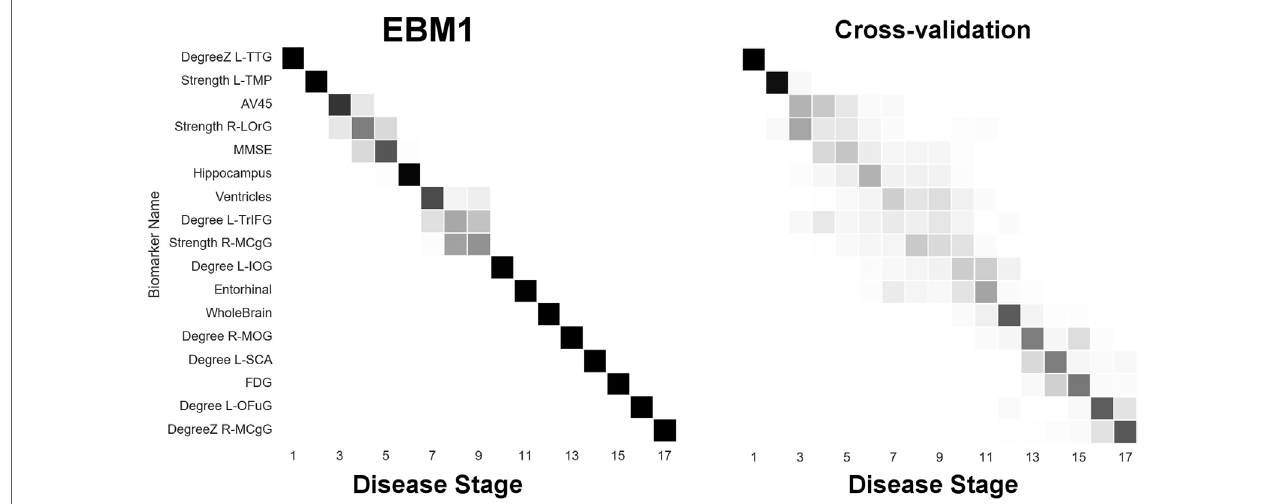
FigUre 6 | EBM for hubs in the brain’s anatomical network, along with selected standard (non-network) biomarkers, built on data from our anatomical connectome cohort, The168 . Left panel: left-right positional variance of the maximum-likelihood sequence. Right panel: cross-validation of the sequence from bootstrapping. Abbreviations: DegreeZ, degree z-score; L, left; R, right; TTG, transtemporal gyrus; TMP, temporal pole; LOrG, lateral orbital gyrus; TrIFG, triangular inferior frontal gyrus; MCgG, middle cingulate gyrus; IOG, inferior occipital gyrus; MOG, middle occipital gyrus; SCA, subcallosal area; OFuG, occipital fusiform